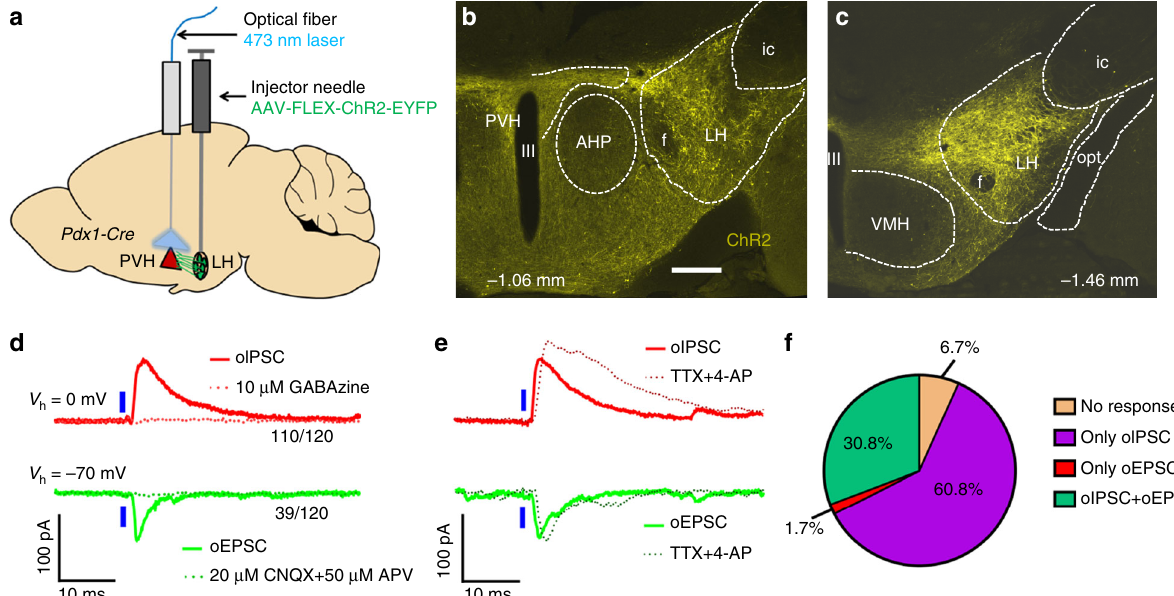
Fig. 1 LH GABA and glutamate neurons send monosynaptic projections to a common subset of PVH neurons. a Experimental schematic. b Representative image showing ChR2-EYFP LH Pdx1 fi bers in PVH. c ChR2 expression in LH Pdx1 neurons. Coordinates in a , b are anterior – posterior (AP) measurements relative to Bregma. III, 3rd ventricle; AHP, anterior hypothalamic area, posterior; f, fornix; ic, internal capsule; LH, lateral hypothalamus; opt, optic tract; PVH, paraventricular nucleus of the hypothalamus; Scale bar = 300 µ m. d Electrophysiology traces from patch-clamp recordings showing optical-evoked inhibitory post-synaptic currents (oIPSCs, top) and optical-evoked excitatory post-synaptic currents (oEPSCs, bottom) in a PVH neuron held at the indicated potentials ( V h ) following 1-ms blue light pulse to LH Pdx1-ChR2 fi bers. Currents can be blocked by ionotropic GABA or glutamate receptor blockers, GABAzine and CNQX+APV, respectively. e Effect of co-application of TTX and 4-AP in oIPSCs (top) and oEPSCs (bottom). f Pie chart showing percentage of PVH neurons receiving excitatory and/or inhibitory inputs from LH Pdx1-ChR2 neurons, as suggested by electrophysiology current responses to blue